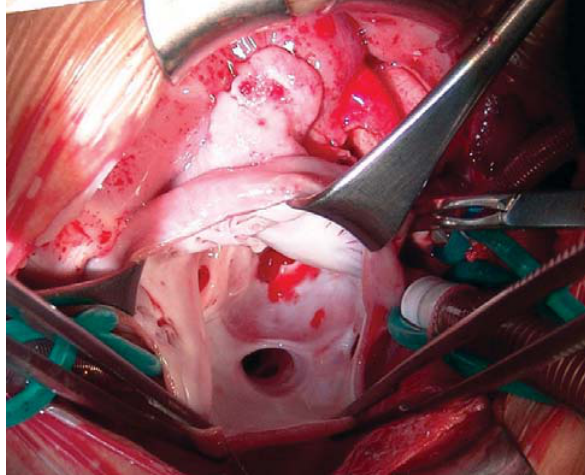
Fig. 5 – Átrio posicionado à esquerda aberto onde se conectam as veias cavas e se observa anomalamente orifícios de veias pulmonares que drenam o pulmão esquerdo. Nota-se o aspecto interno liso que indica átrio anatomicamente